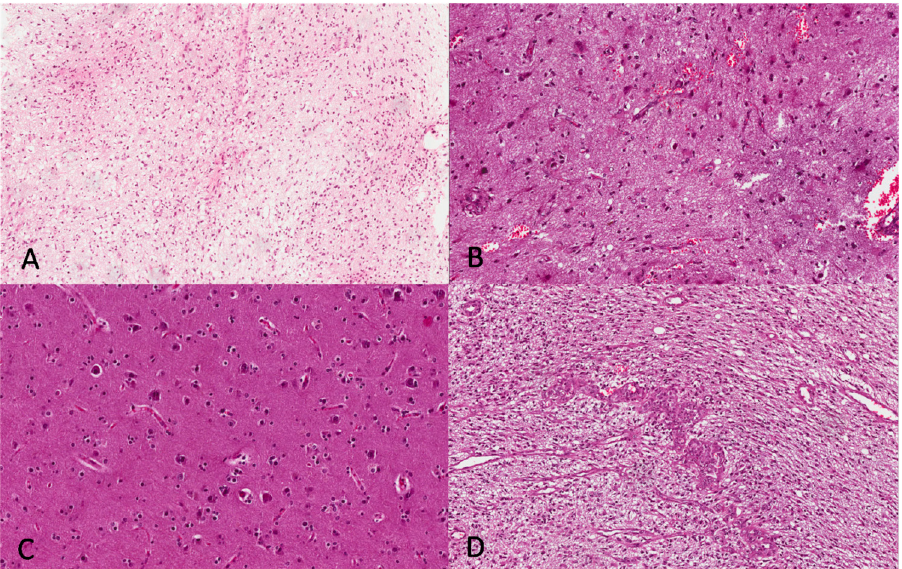
Figure 4. Histopathology of FLAIR hyperintensity region. ( A ) Focal to diffuse infiltration of white matter by tumor cells is seen (H&E; original magnification 100×). ( B ) Reactive astrogliosis of the white matter with gemistocytic features is shown (H&E; original magnification 200×). ( C ) Grey matter exhibiting perineuronal satellitosis (H&E; original magnification 200×). ( D ) A minority of samples show GBM morphology with foci of MVP (H&E; original magnification 100×). Table 1. Differential distribution of the histological features between EC and FLAIR regions.